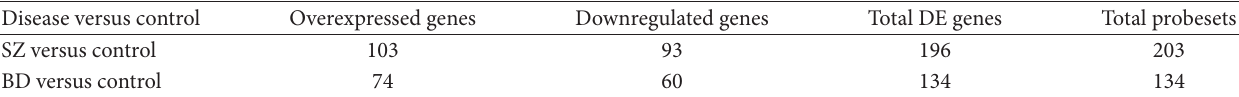
T 1: Number of DE genes and probesets, in SZ and BD patients as compared to healthy controls. Genes are characterized as overexpressed when they present positive FC and 10000 genes of the Affymetrix HG-U95 platform, we derived a much smaller number of probesets and genes. > |0.37| Disease versus control